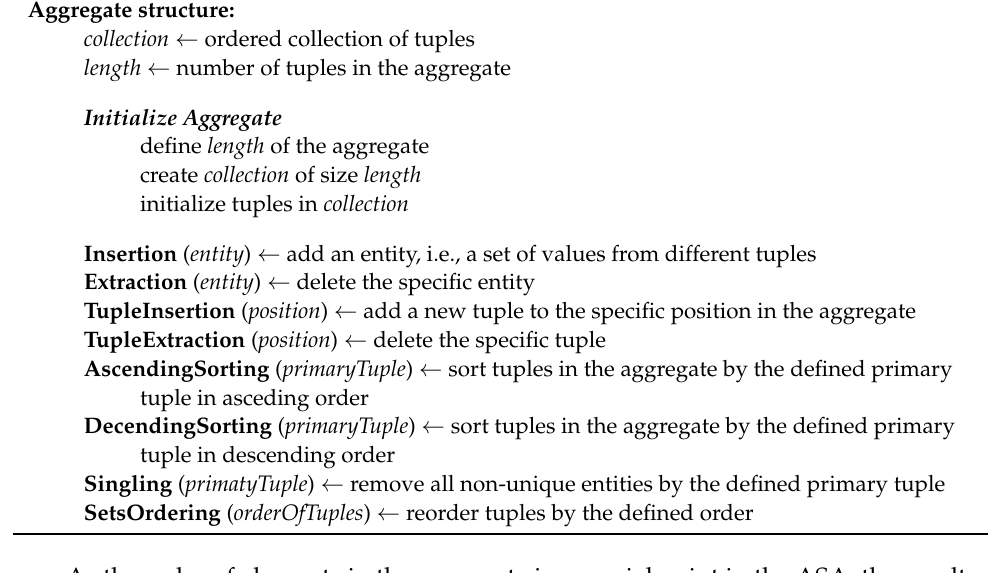
Figure 3. An example of two incompatible aggregates.